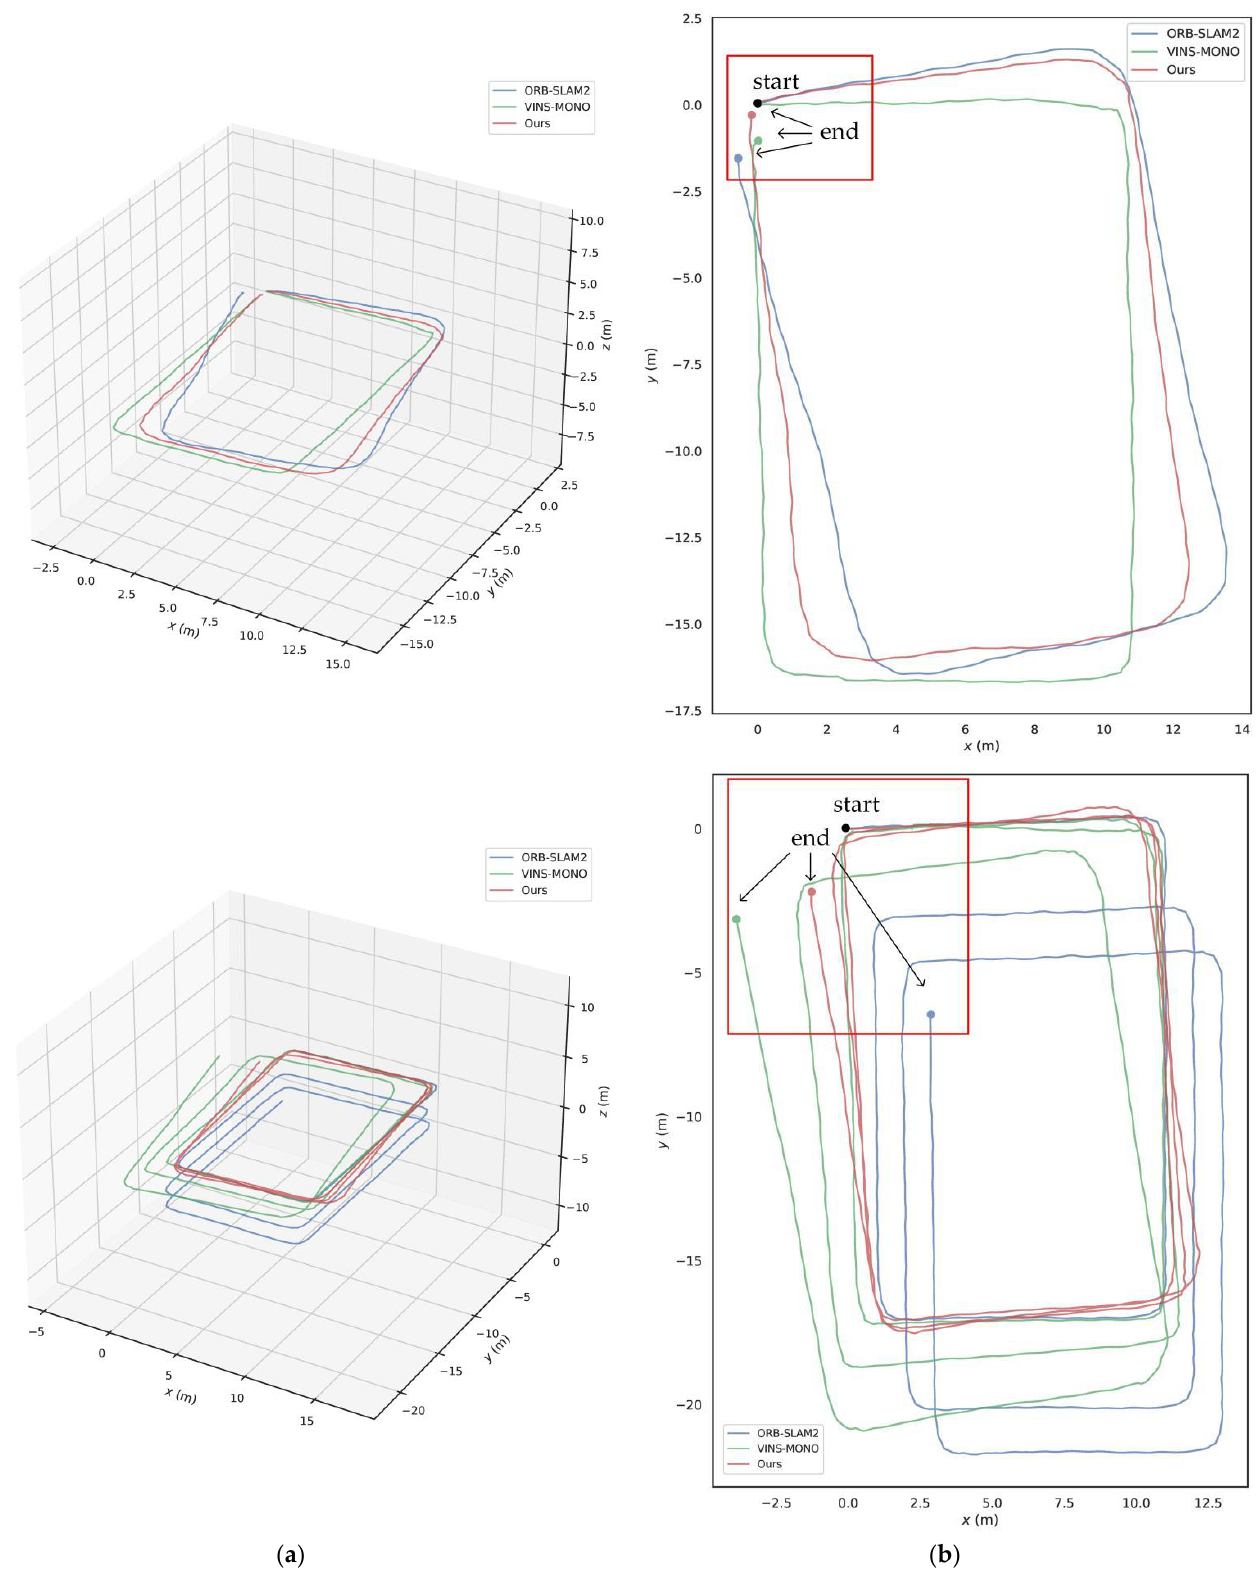
Figure 14. Results of the circular trajectory experiment: ( a ) trajectories of this method (red) and each comparison group; ( b ) comparison of the starting and ending points of the three trajectories — the distance between this method and the starting point is the smallest.